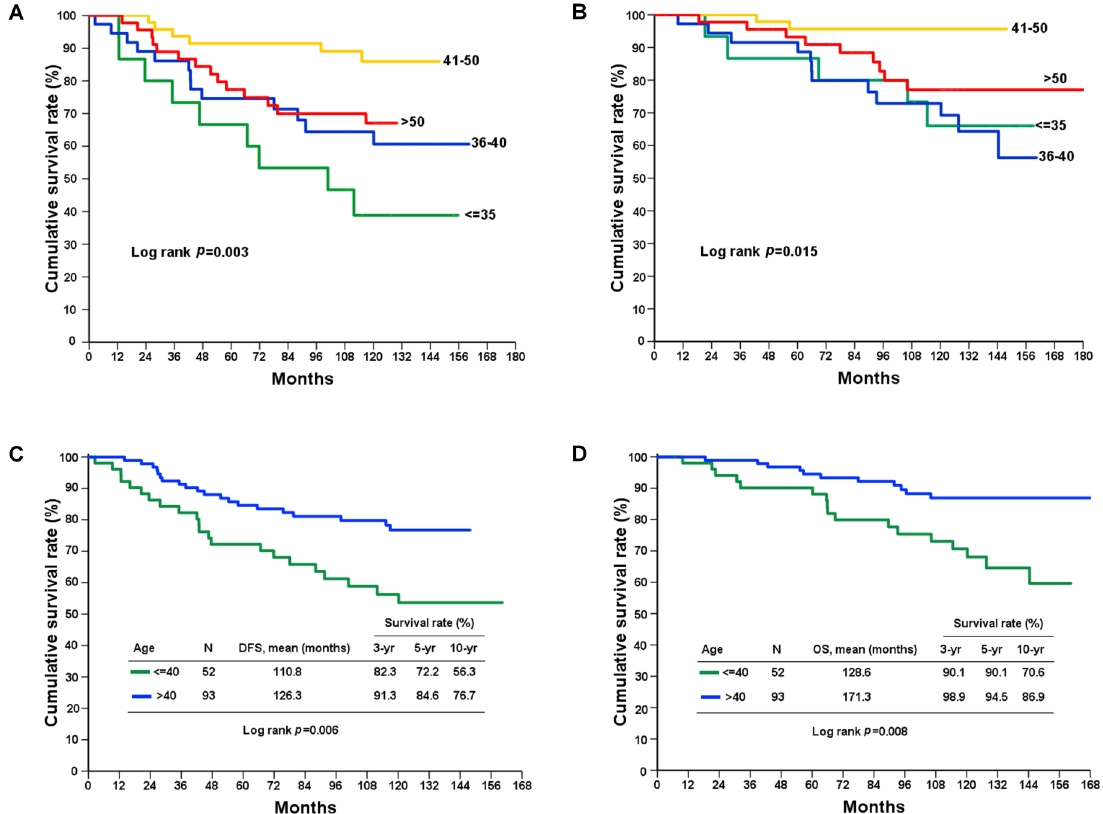
Fig 3. Kaplan-Meier survival curves for breast cancer patients. The young age group of patients had worse prognosis than other age groups in (A) disease-free ( p = 0.003) and (B) overall survival ( p = 0.015). Patients younger than 40 years had worse prognosis than the older age group in (C) disease-free ( p = 0.006) and (D) overall survival ( p = 0.008).